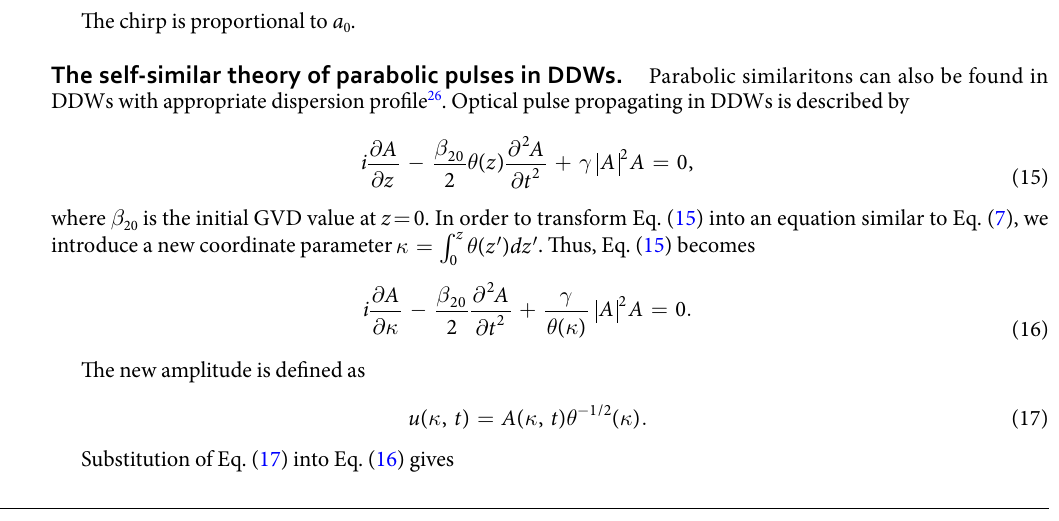
where ϕ is the initial phase of input pulses. The corresponding chirp is 0